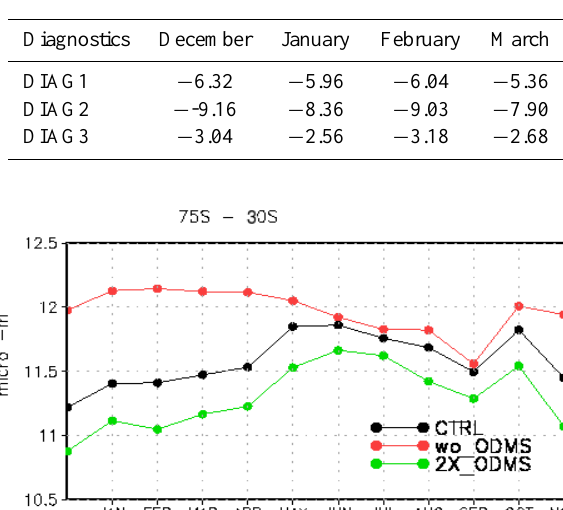
Fig. 3. Same as in Fig. 2, but, for, the cloud droplet effective radii ( µ m).